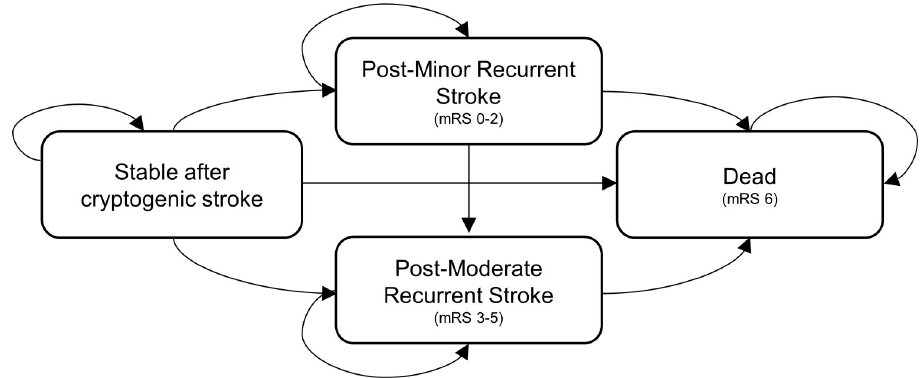
Fig 2. Markov model. The Markov model shows four health states: stable after cryptogenic stroke, post-minor recurrent stroke, post-moderate recurrent stroke, and death. We used a modified Rankin Scale to categorize strokes. Abbreviations. PFO, patent foramen ovale; mRS, modified Rankin